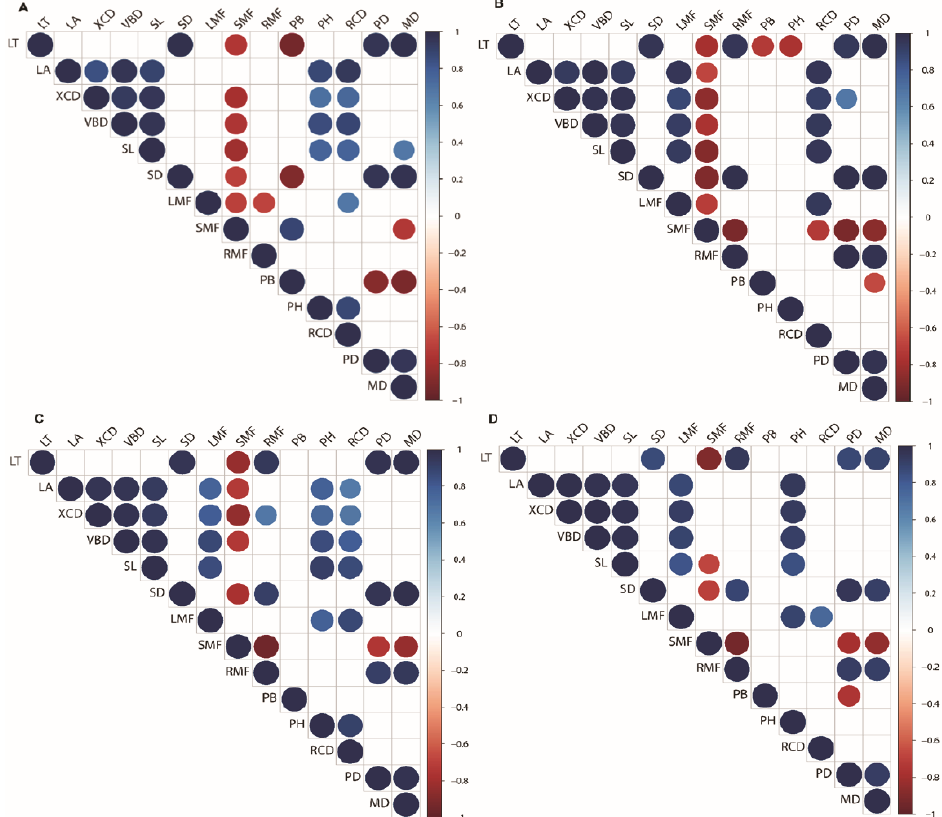
Figure 6. Pearson’s correlation coefficients of morpho-functional plant traits of two-year-old seedlings of L. gmelinii ( A ), P. koraiensis ( B ), F. mandshurica ( C ), and T. amurensis ( D ) in northeast China.